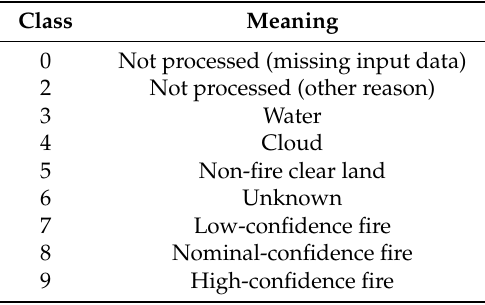
Table 1. MOD14A1/MYD14A1 fire mask pixel